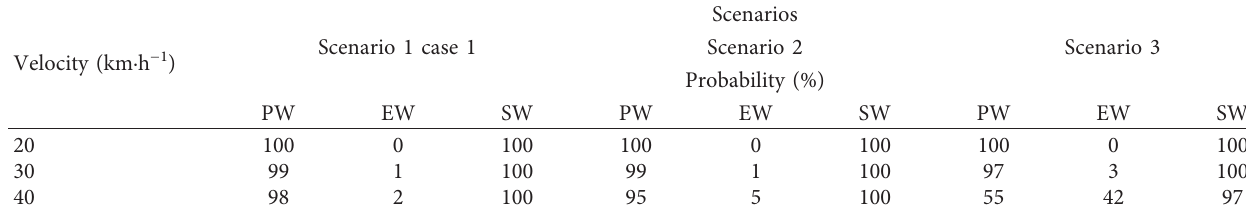
Table 4: Test results for scenarios 2 and